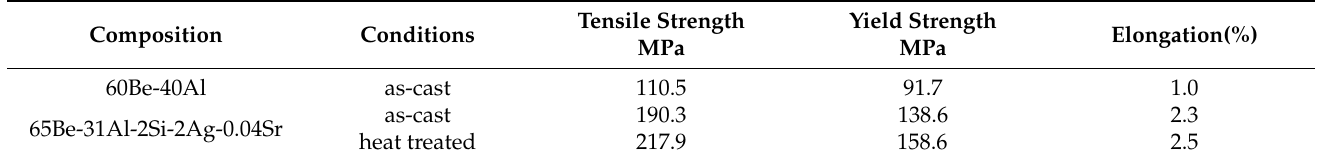
Table 5. The mechanical properties of Be-Al alloys (as-cast and heat treated) [31].